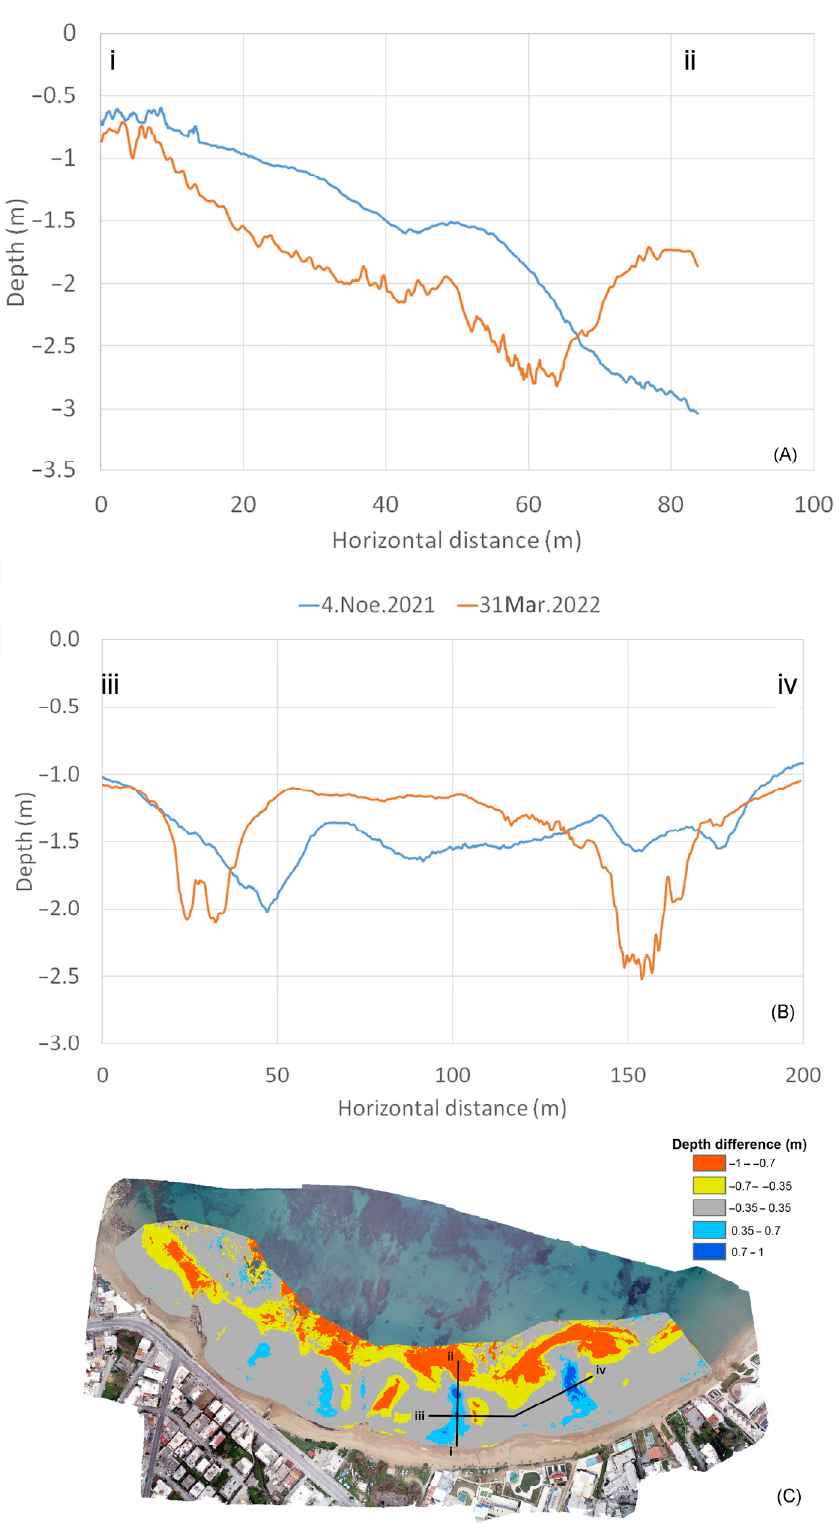
Figure 6. Temporal bathymetric profiles: ( A ) across-shore (i–ii); and ( B ) along-shore (iii–iv); ( C ) Legend map showing the profiles on the bathymetry difference map.